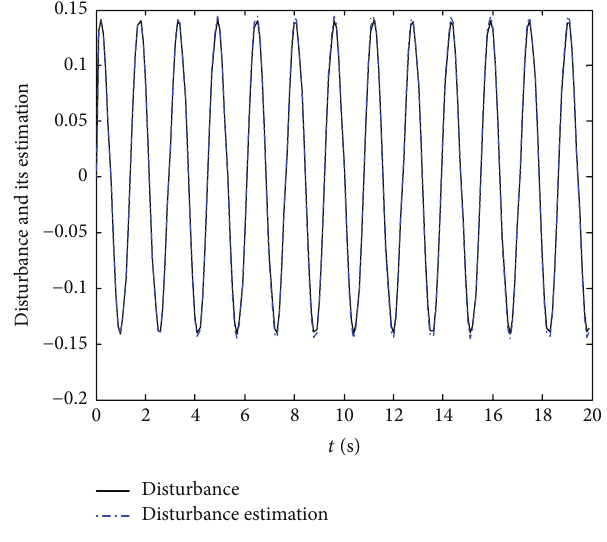
Figure 1: Disturbance and its estimation.